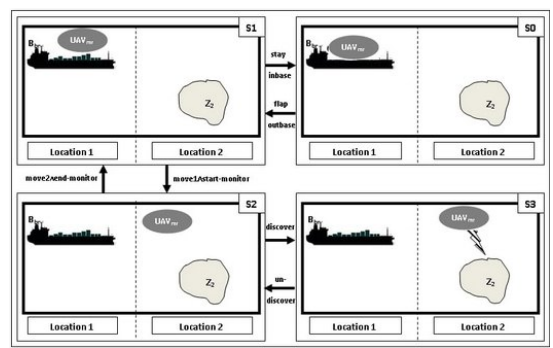
Figure 10: A state transition system for the UAV-M domain.